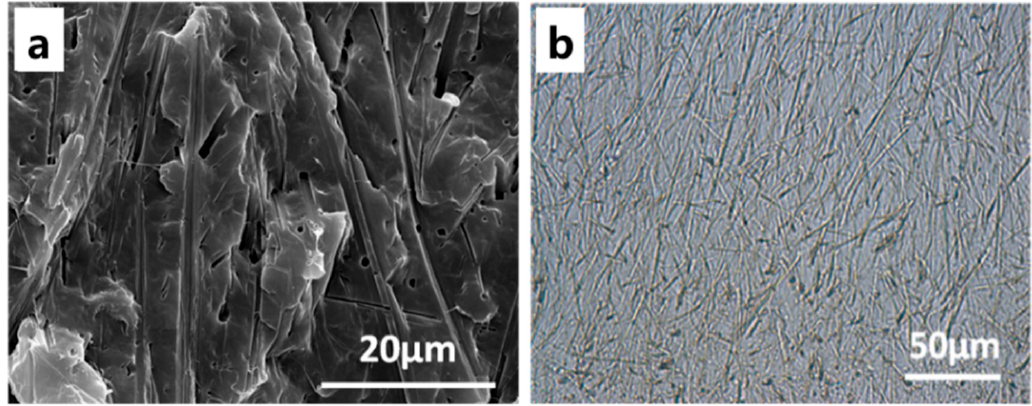
Figure 5. ( a ) SEM image of MPT5-130-re after being immersed in PBS for 72 h; ( b ) OM photo at 80 °C.